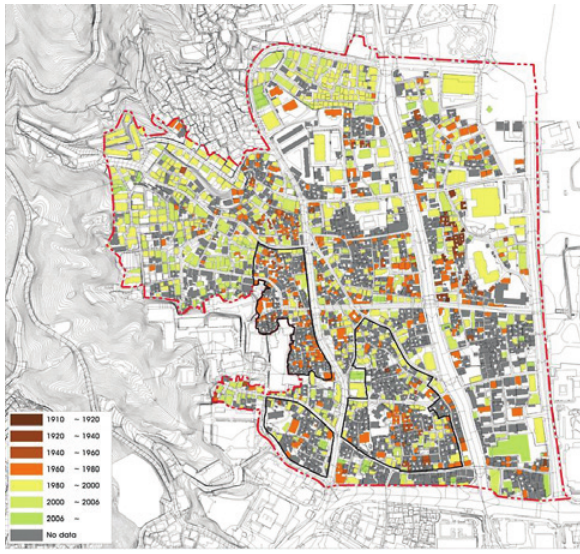
Figure 11. Construction Year of Buildings (source: Final Report for Seochon district plan,